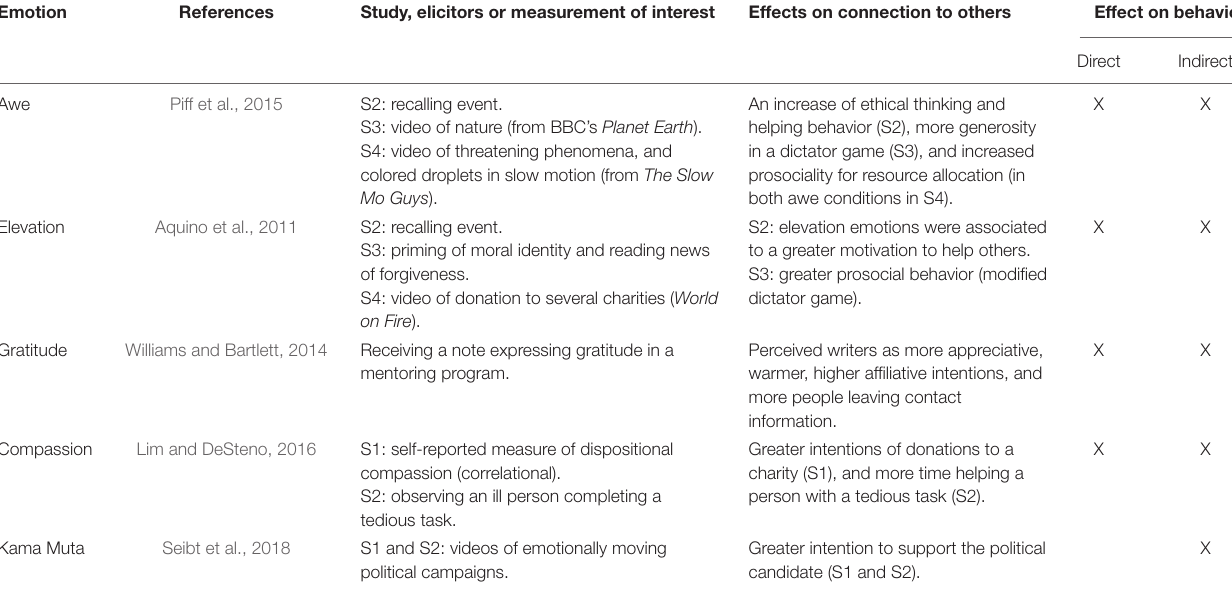
TABLE 1 | Review (summarized) of the effects of STEs on connection with others.